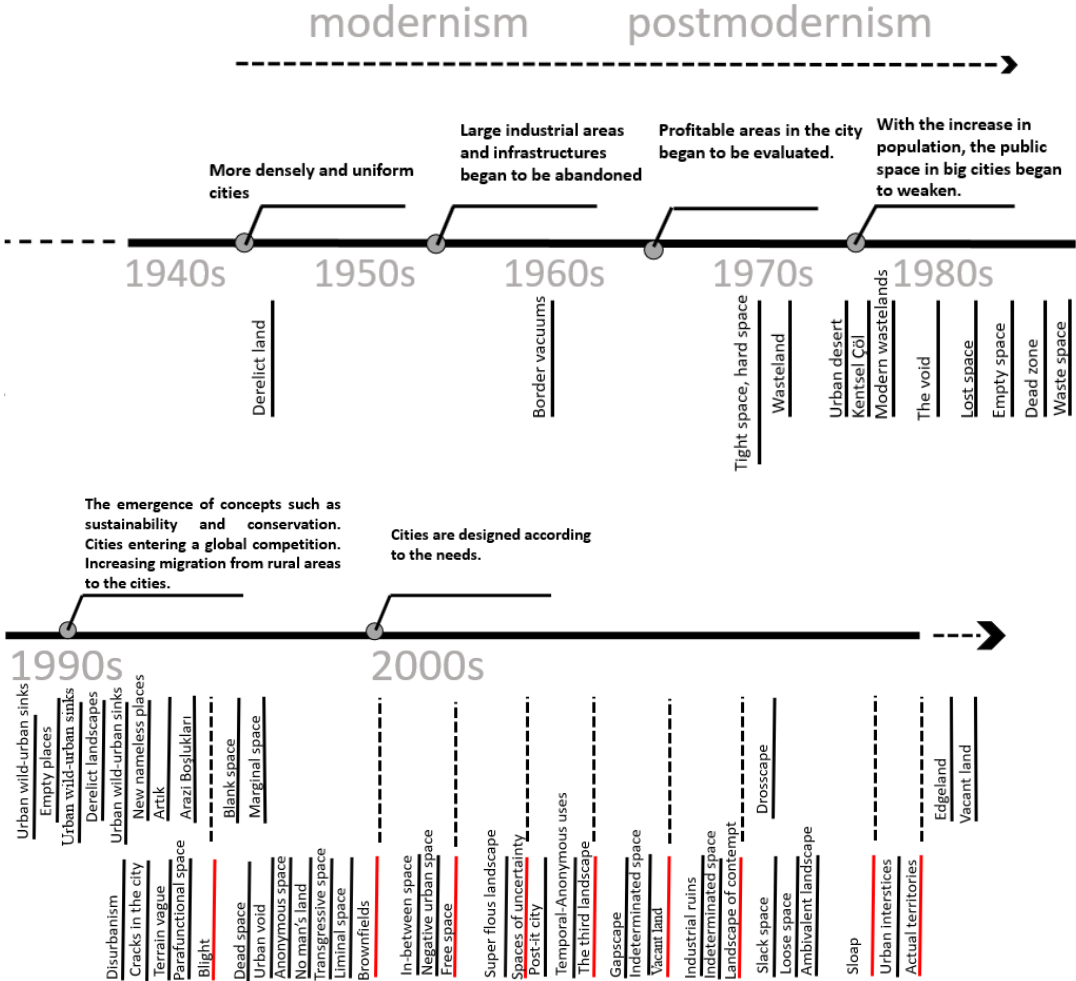
Figure 1 The stages of formation of lost spaces in the historical process and the terms used for such spaces (created by the authors based on Doron, 2007; Girolama, 2012; Boz,